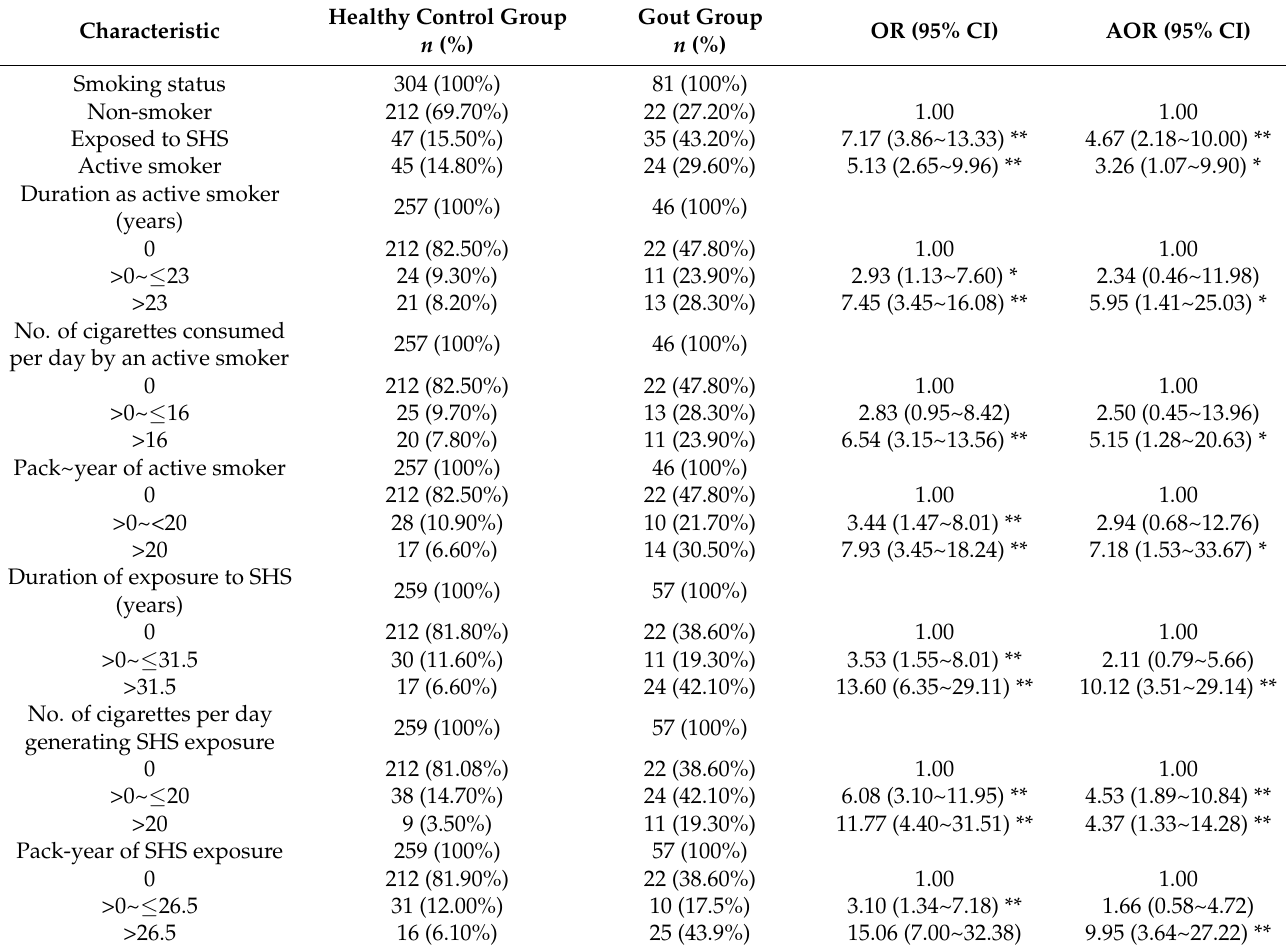
Table 3. Odds Ratio (OR) and Adjusted Odds Ratio (AOR) of The Risk of Gout ( N = 385). Healthy Control Group Gout Group OR (95% CI) AOR (95% CI) Characteristic n (%) n (%) Smoking status 304 (100%) Exposed to